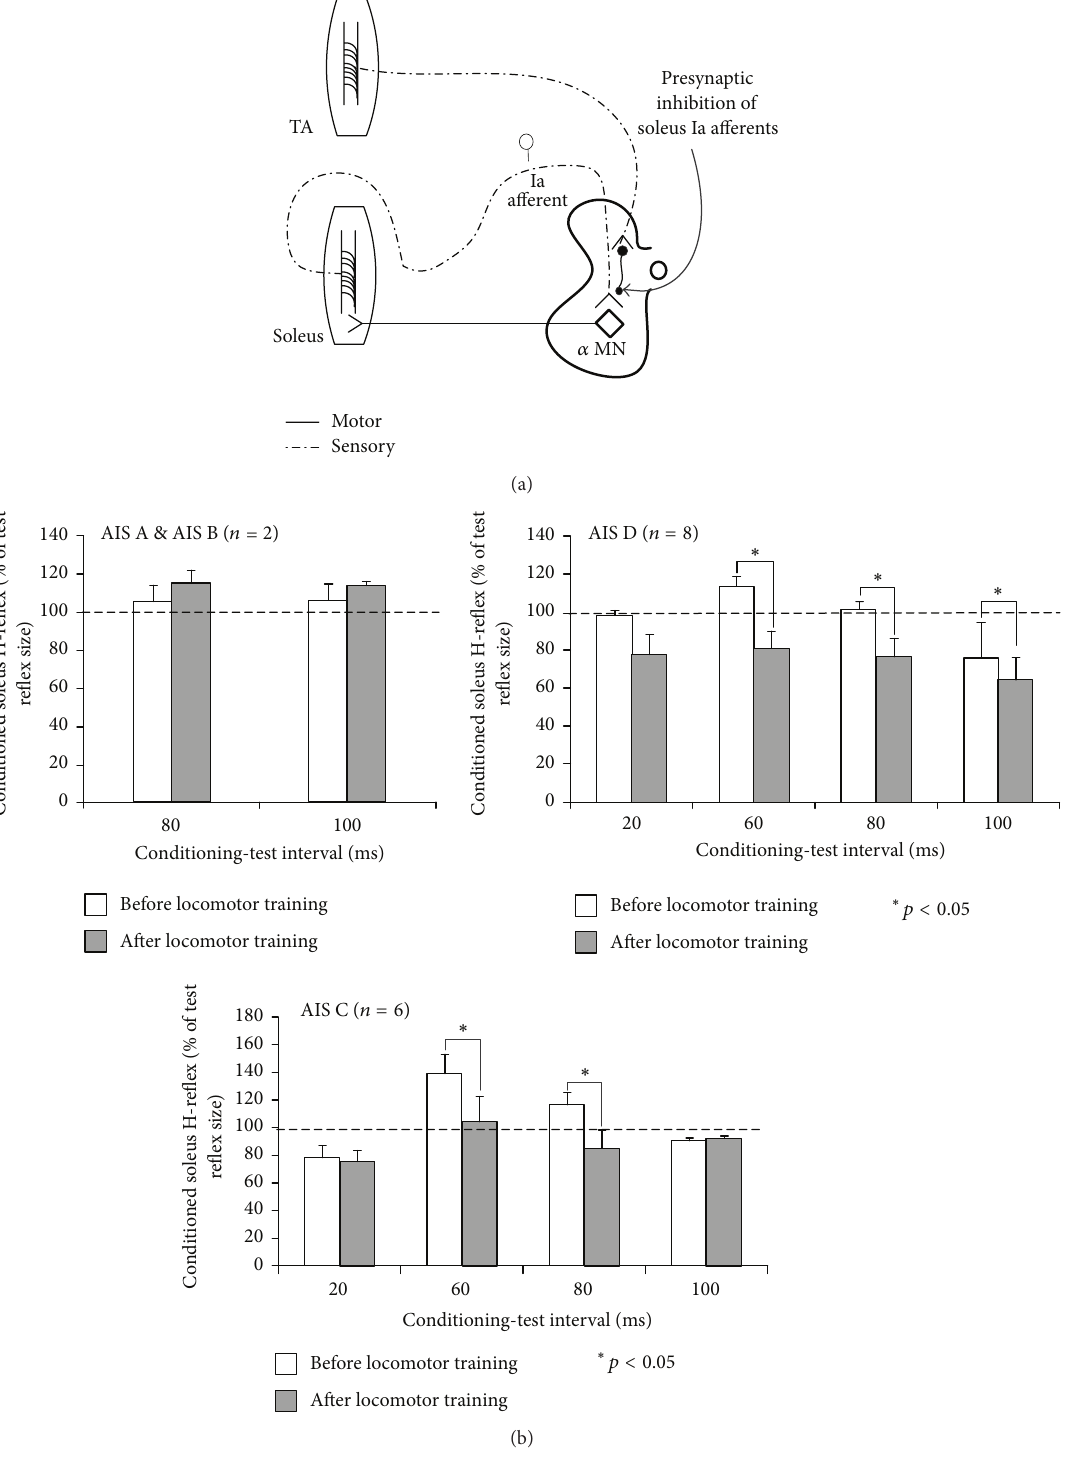
Figure 3: Functional reorganization of presynaptic inhibition of soleus Ia afferents after locomotor training in SCI. (a) Schematic diagram of the neuronal pathway of presynaptic inhibition of soleus Ia afferents. In this paradigm, presynaptic inhibition of soleus Ia afferents is induced by a conditioning afferent volley following common peroneal nerve stimulation at long conditioning-test (C-T) intervals. (b) Mean amplitude of the conditioned soleus H-reflex as a percentage of the unconditioned H-reflex recorded at each C-T interval tested before and after locomotor training from the right leg, grouped per AIS, in the seated position. ∗ 𝑝 < 0.05 indicate statistically significant differences of the conditioned H-reflexes recorded before and after locomotor training. Data adopted and modified from